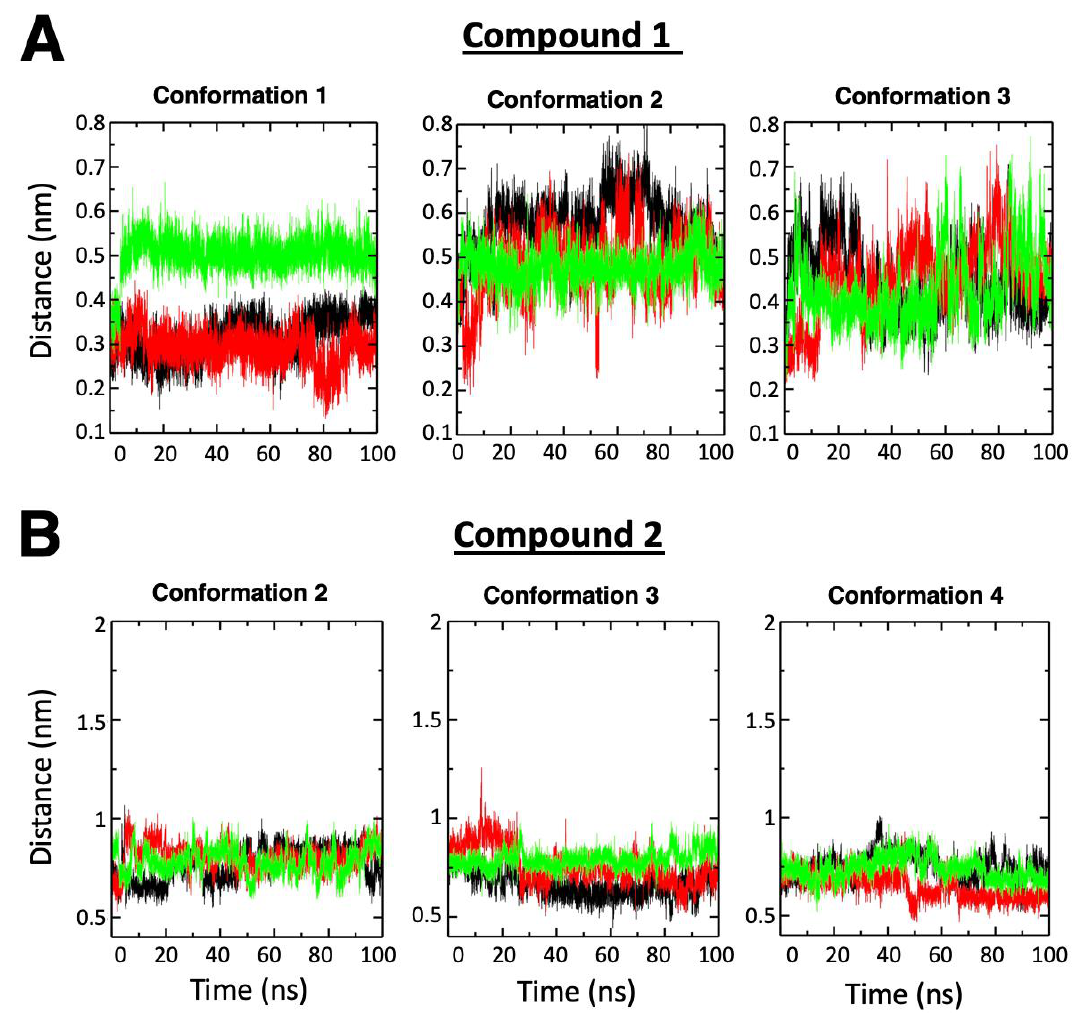
Figure 3. The center-of-mass distances between ligand and the respective binding site on RT during the molecular dynamic (MD) simulations. Data are shown for ( A ) compound 1 and ( B ) compound 2, calculated using independent triplicates (black, green, and red) of 100 ns trajectories. For compound 2, only the results of the three setups that exhibited stable ligand binding (i.e., conformation 2, 3, and 4) are shown. The remaining data are shown in Supplementary Figure S3.